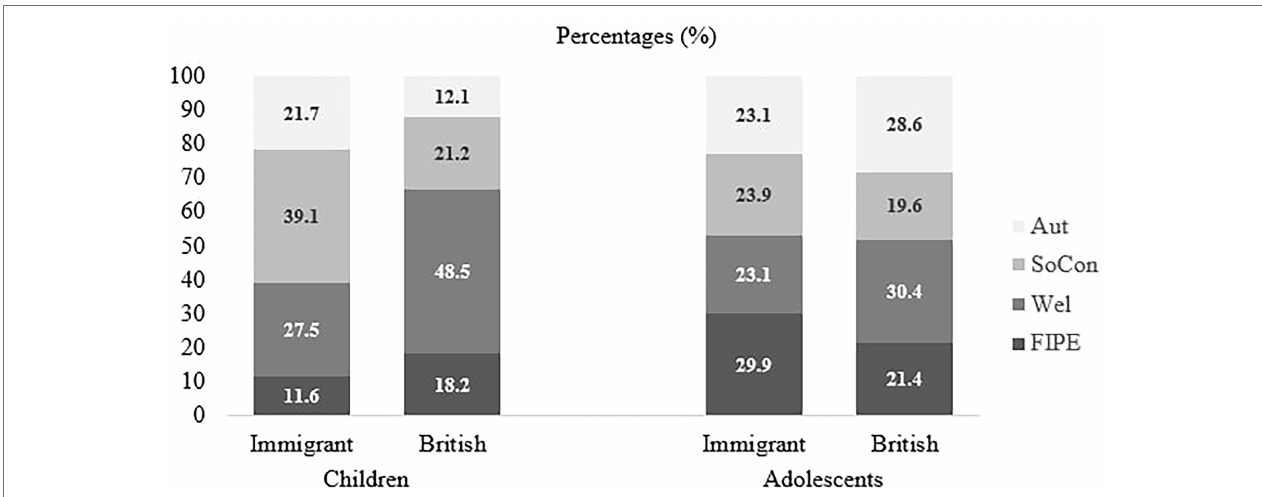
FIGURE 4 | Percentages of participants reasoning of individual evaluation of challenger by exclusion condition and age group. FIPE, Fairness and Individual Rights and Prejudice and Equality; Wel, Welfare; SoCon, Social and Group Norms, Group Dynamics and Functions and Repercussions and Representation Management; and Aut, Autonomy. Numbers represent the percentages of participants within “Immigrant” and “British”